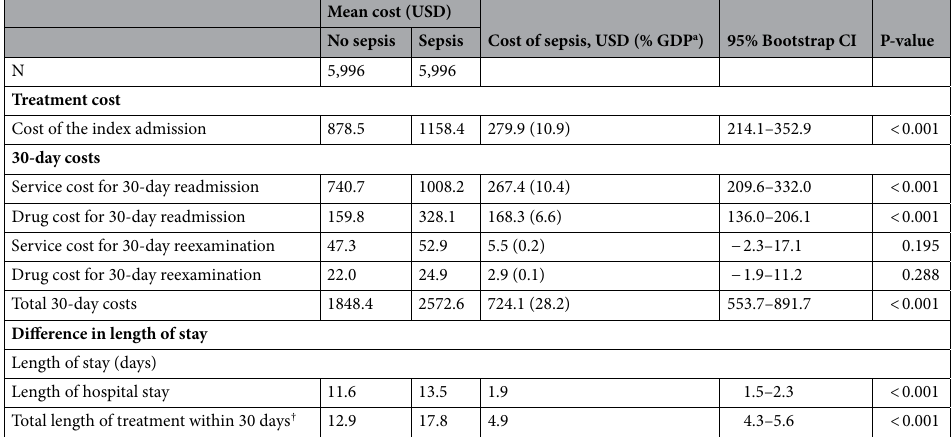
and Supplemental Table 3 show the impact of sepsis complications on secondary outcomes, including readmis- sion, reexamination, and LOS of patients. Sepsis complications significantly increased the LOS of patients, at an